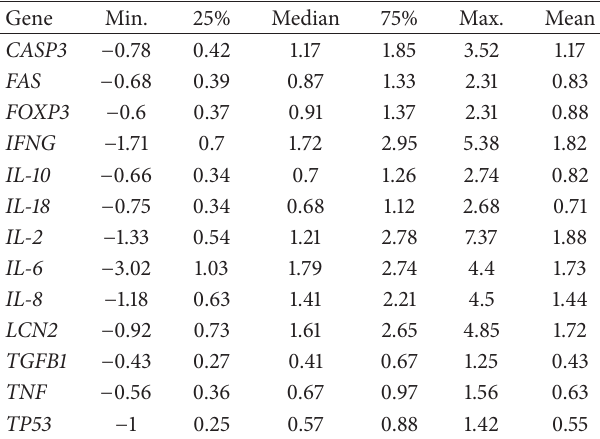
Figure 1: Best-fit surface representation of donor age and recipient BMI influence on graft function 6 months after transplantation. Table 3: Expression level of the studied genes.